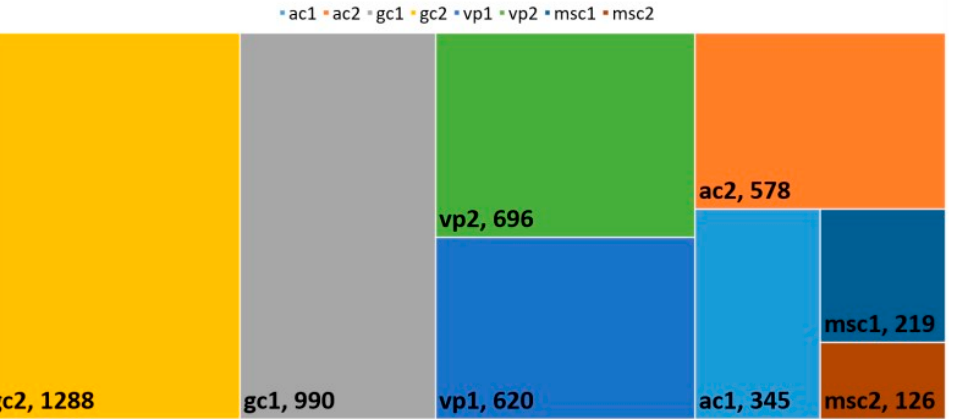
Figure 8. Treemap diagram showcasing the distribution of annotated distresses. ac: Area cracking, gc: general cracking, vp: visco-plastic deformations, msc: miscellaneous distresses 1: Low severity, 2: High severity requiring intervention.